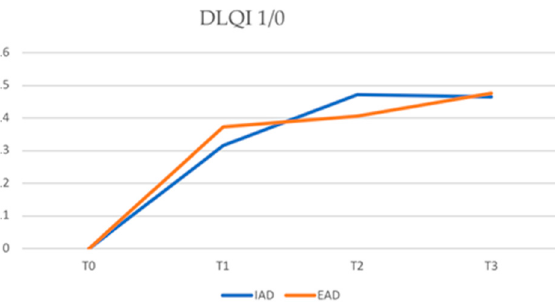
Figure 5. Proportion of patients achieving a DLQI of 1/0 in IAD and EAD. DLQI = dermatology life quality index (IAD = intrinsic atopic dermatitis; EAD = extrinsic atopic dermatitis).